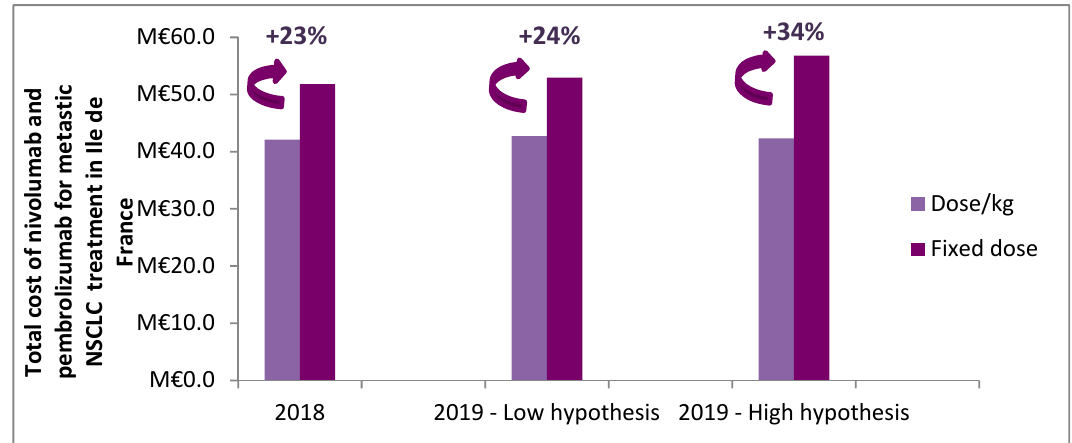
Figure 5. Estimate of the extra cost of switching to the fixed dose compared to the weight-based dose in